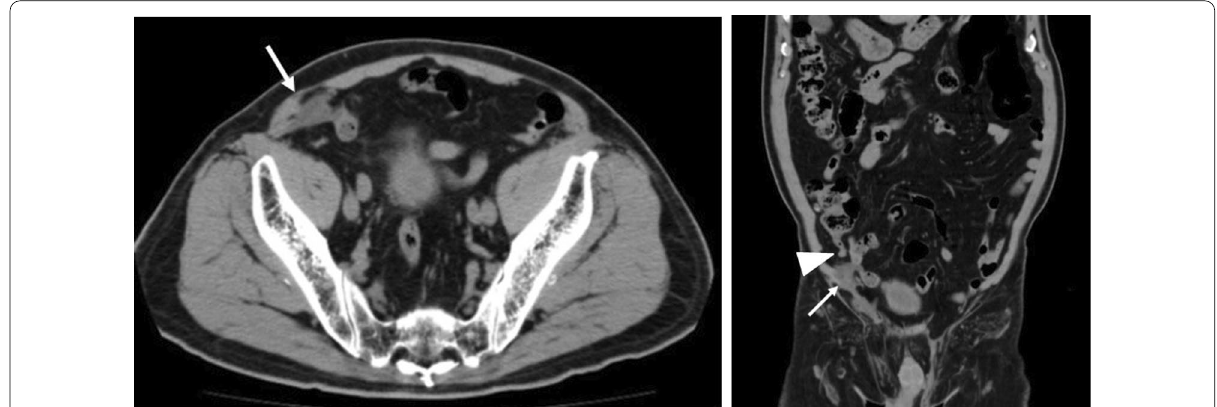
Fig. 2 Computed tomography (CT) findings 6 years prior to surgery. 2–1 The CT scan shows fluid around the plug mesh, which was considered to be the cause of mild inflammation (arrow). 2–2 The CT scan shows that the mesh (arrow) and appendix (arrowhead) were not in contact